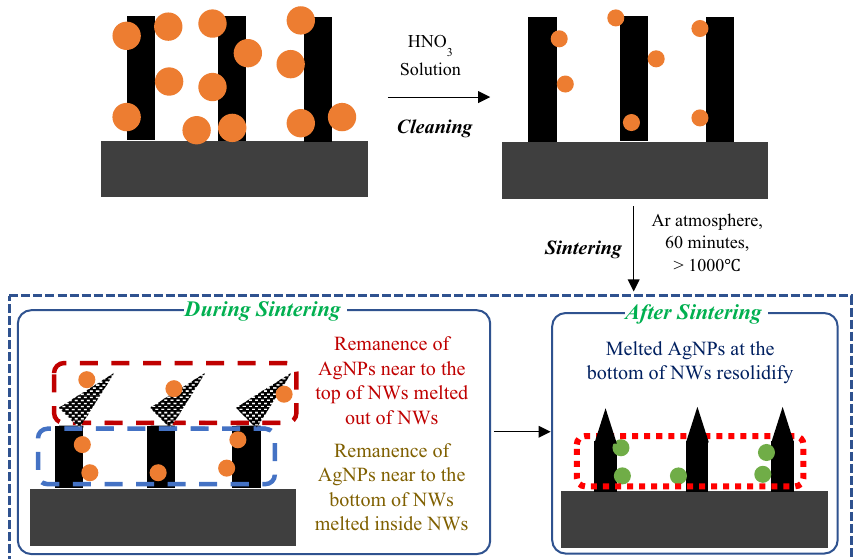
Figure 7. Schematic of Ag particles remanence (brown color filled circle) on the NWs after dipping in HNO 3 solution. During sintering, the AgNPs attached to the tips of the porous NWs (white and black color pattern filled in a triangular shape) wiped away along the NWs. The AgNPs are present at the interface of the NWs base, and the Si/PSi meltdown and resolidifies after